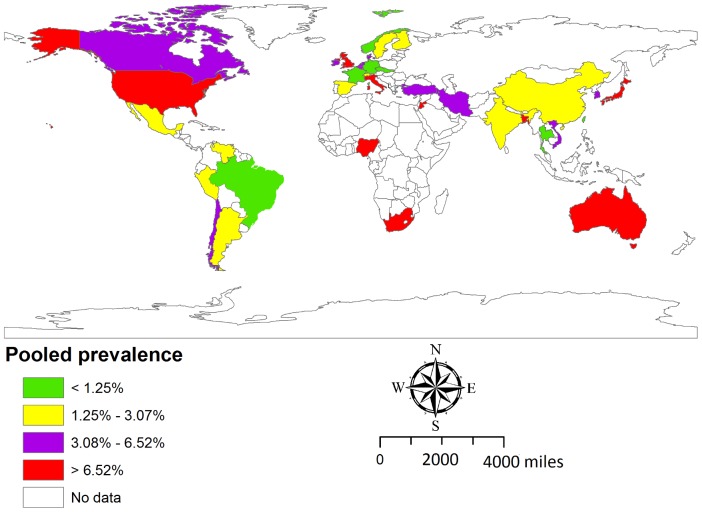
Estimated prevalence of E. coli O157 in cattle in different countries.The prevalence is based on a meta-analysis of 140 studies comprising 220,427 cattle from different production system. Regional adjusted prevalence is denoted by different colors and it represents the quartile distribution of prevalence by country.